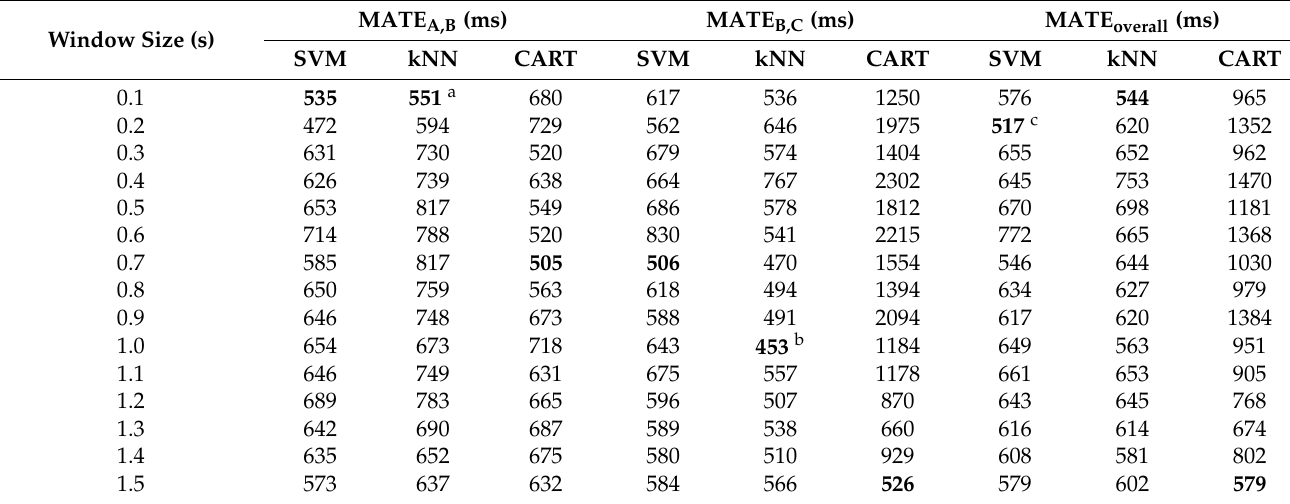
Table 10. The MATE A,B , MATE B,C and MATE overall of FS patients using different machine learning models vs. difference window sizes